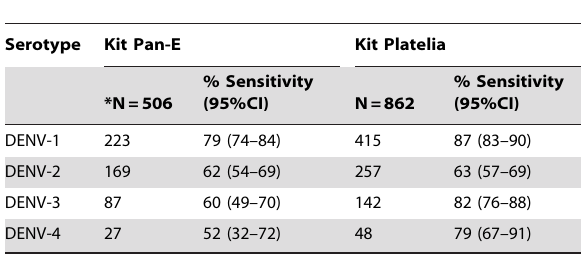
Table 3. NS1-sensitivity in the context of DENV serotype.